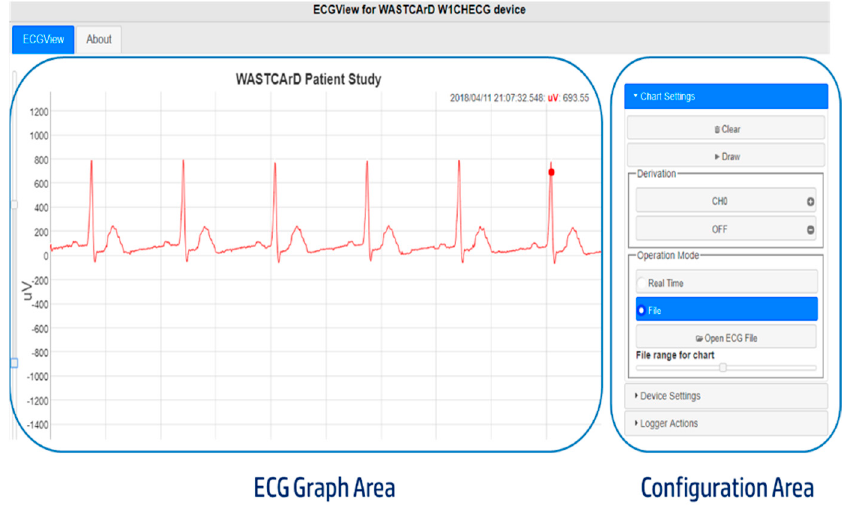
Figure 11. ECGView application main screen.